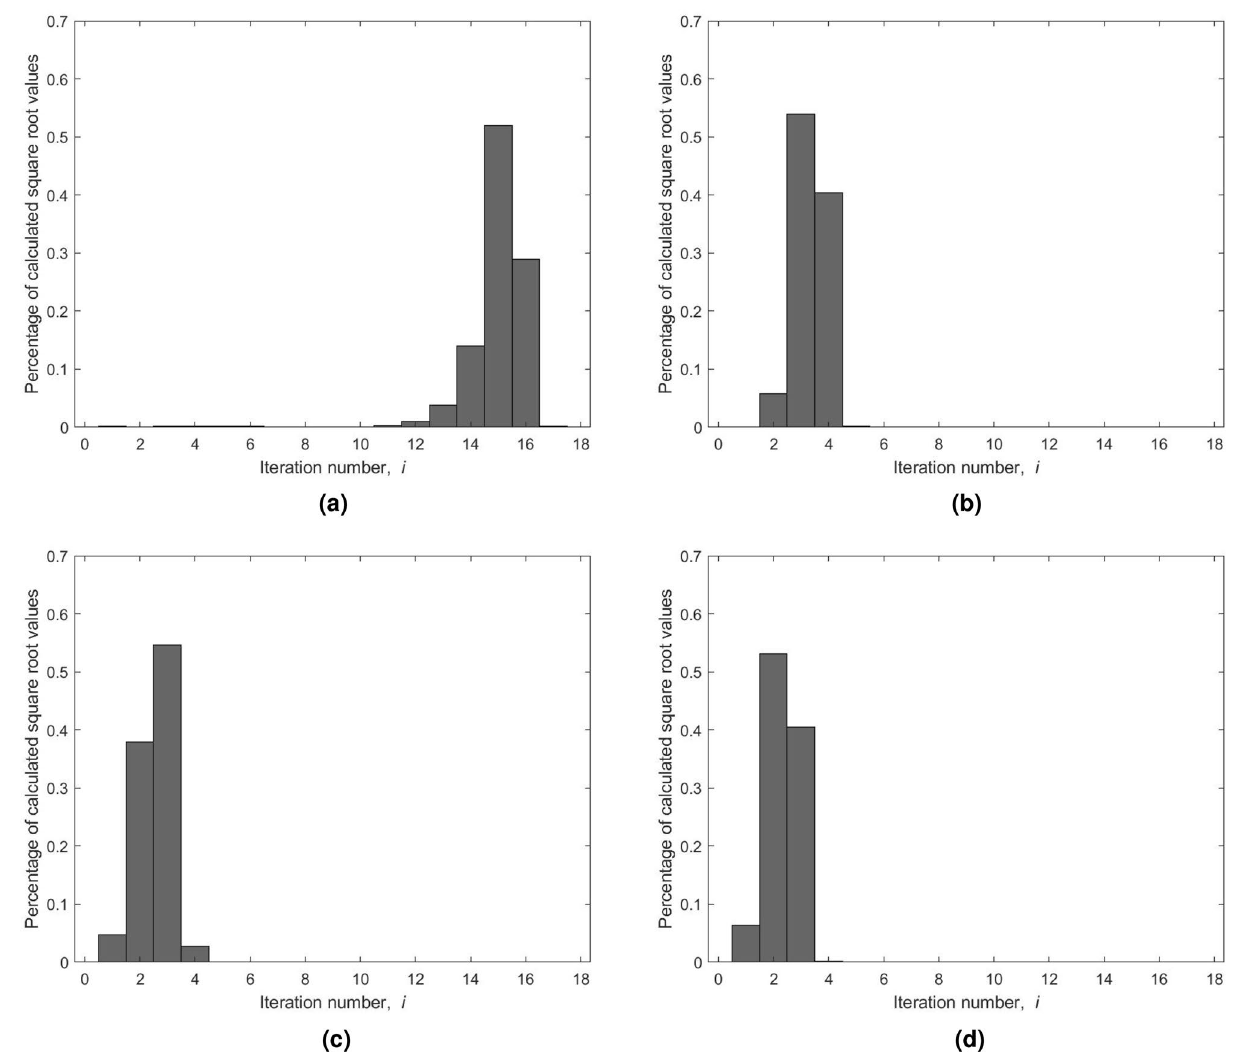
Figure 7. Distribution of the number of iterations of Newton–Raphson’s method using different seed values: ( a ) seed is equal to x . ( b ) Seed is equal to 3 × 2 algorithm based on bit manipulation, s 0 . Seed